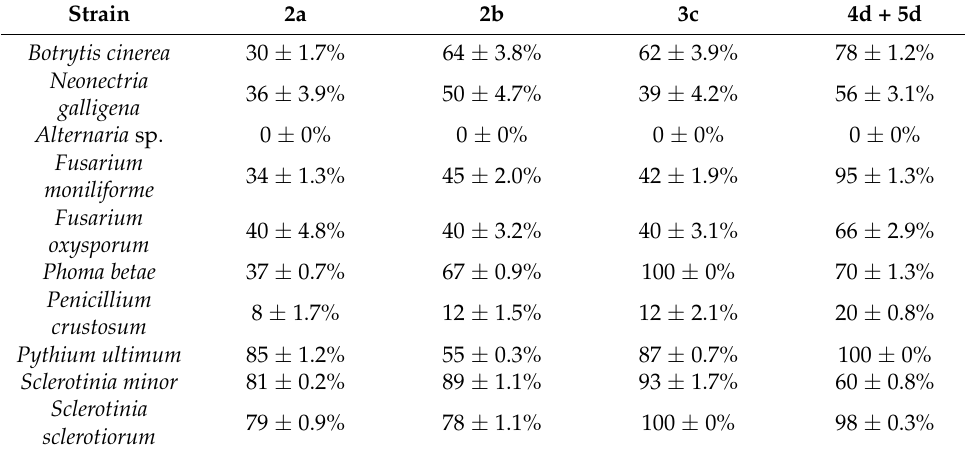
ocholic acid, 4d + 5d = secosteroids from hyodeoxycholic acid. Results of the screening using bile acids at the concentration of 1000 μ g/mL showed that P. betae, S. minor and F. moniliforme were sensitive to the tested compounds (with a growth inhibition equal or greater than 80%). Namely, P. betae proved to be particularly sensitive to three of the bile acids tested: deoxycholic acid 1b , hyocholic acid 1c and